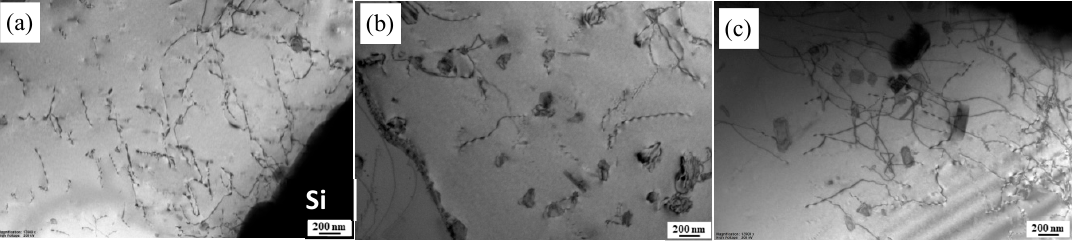
Figure 11. Optical microstructures at the thermo ‐ mechanically affected zones (TMAZs) of FSW joints under different states: ( a ) T1; ( b ) T4; ( c ) T6.